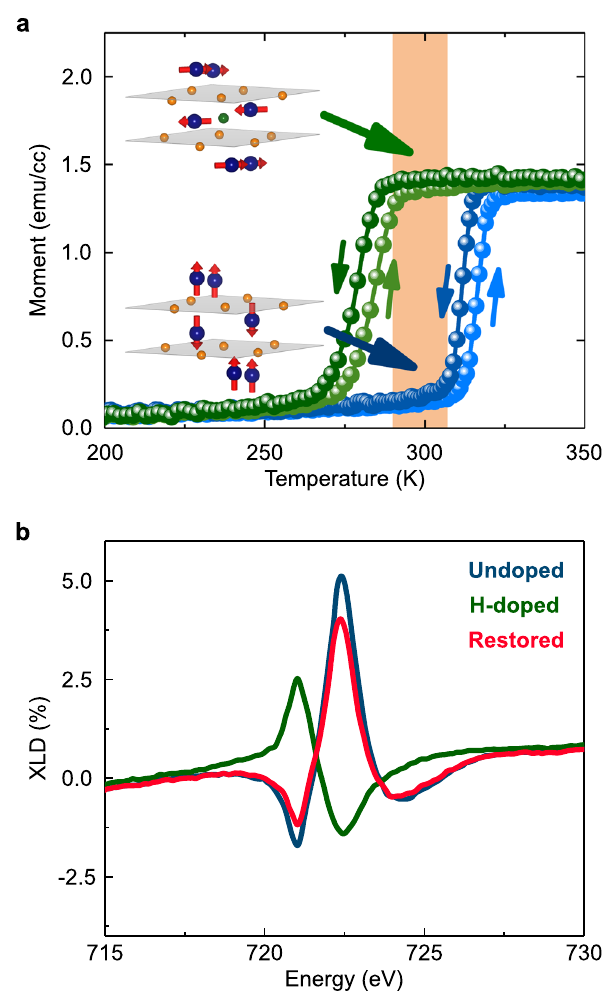
Fig. 4 Room-temperature reversible control of the antiferromagnetic Néel vector orientation and the Morin transition. a M ( T ) curves of undoped α -Fe 1.97 Rh 0.03 O 3 (blue) and H-doped α -Fe 1.97 Rh 0.03 O 3 (green) samples during up/down temperature sweeps in a measuring fi eld of 500 Oe (following fi eld cooling at 500 Oe). The insets correspond to partial crystal unit-cells in undoped (lower) and H-doped (upper) scenarios, with 90° switched L orientations in the orange shaded temperature region. b XLD spectra at the Fe L 2 edge of the undoped, H-doped and restored α - Fe 1.97 Rh 0.03 O 3 samples at 286 K, exhibiting reversal of dichroism, and thereby the Néel vector orientation, as shown in the inset of ( a ). Detailed reversibility results are given in